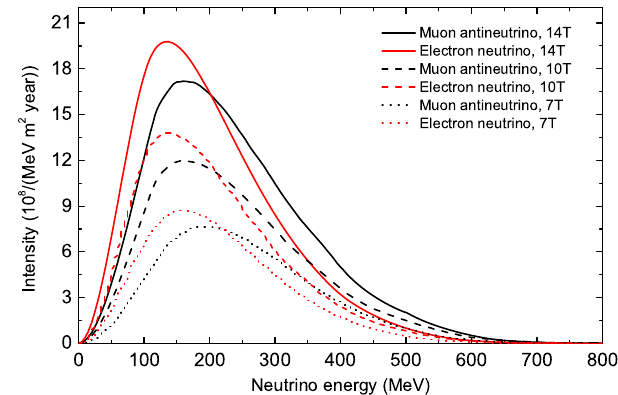
FIG. 18. Muon antineutrino energy spectra at the far detector of 150 km.